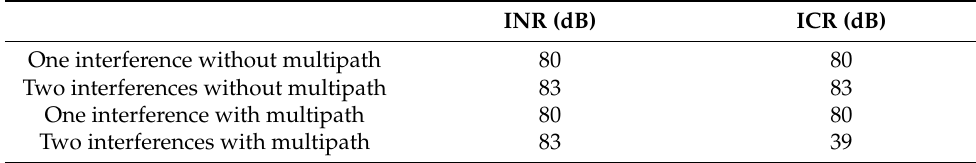
Table 3. ICR with SOP in different conditions.